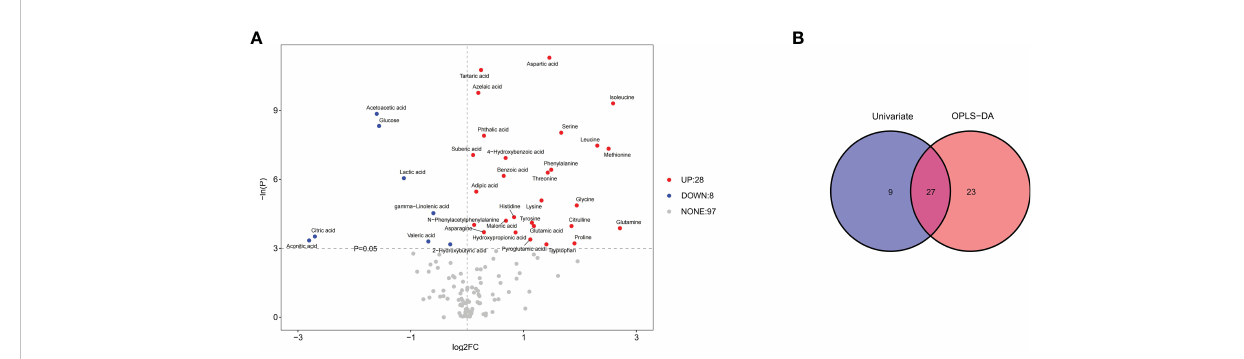
FIGURE 5 (A) Volcano plot of univariate statistics across the control and WSL groups. In the volcano plot, 36 differentially expressed metabolites (red and blue) and 97 nondifferentially expressed metabolites (gray) were determined under the conditions of fold change ≥ 0 and p ≤ 0.05. The red and blue dots indicate upregulated and downregulated metabolites, respectively. (B) Venn diagrams of differentially expressed metabolites screened by multivariate (OPLS-DA) and univariate analyses. Univariate analysis was performed by Student ’ s t test or the Wilcoxon test based on whether the data were normally distributed.